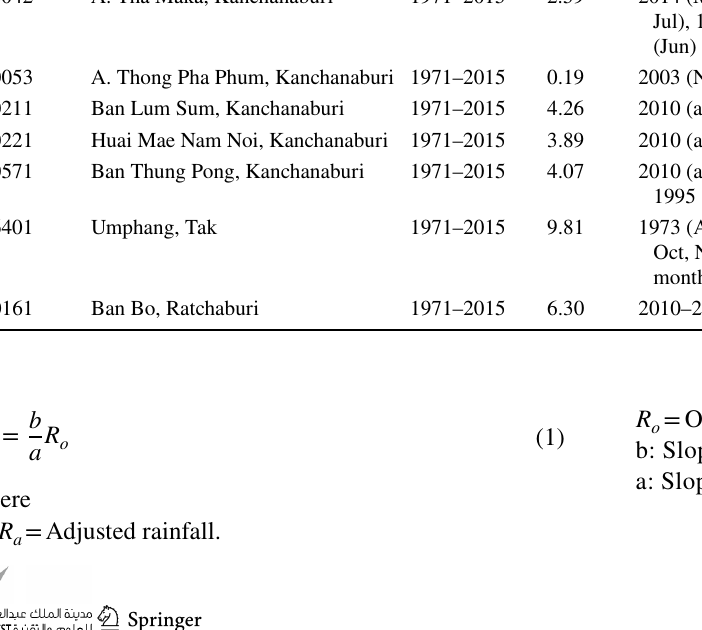
Missing missing data